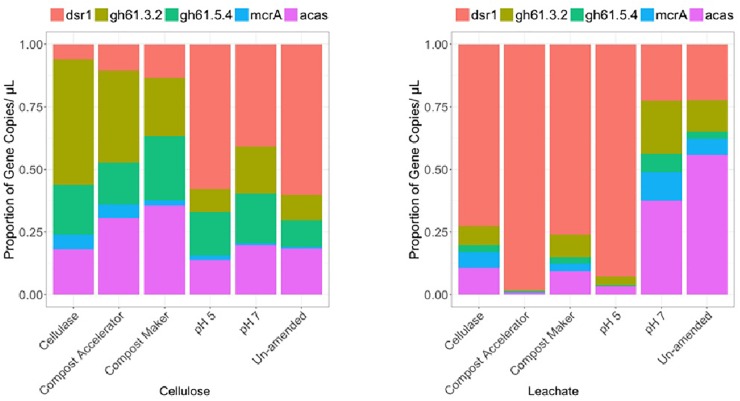
Community differences for cellulose and leachate by differential relative abundances of gene copies detected within the surrogate waste for dissimilatory sulfate reductase (dsr1), glycoside hydrolase family 61 (gh61.3.2 and gh61.5.4), methyl co-enzyme M (mcrA), and acyl co-enzyme A synthase (acas) genes.